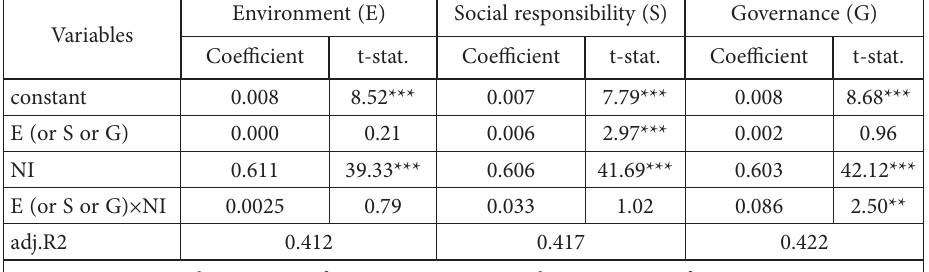
Table 8. Additional analysis of sustainable management activities and the persistence of sustainable management Panel A: Earnings forecasting